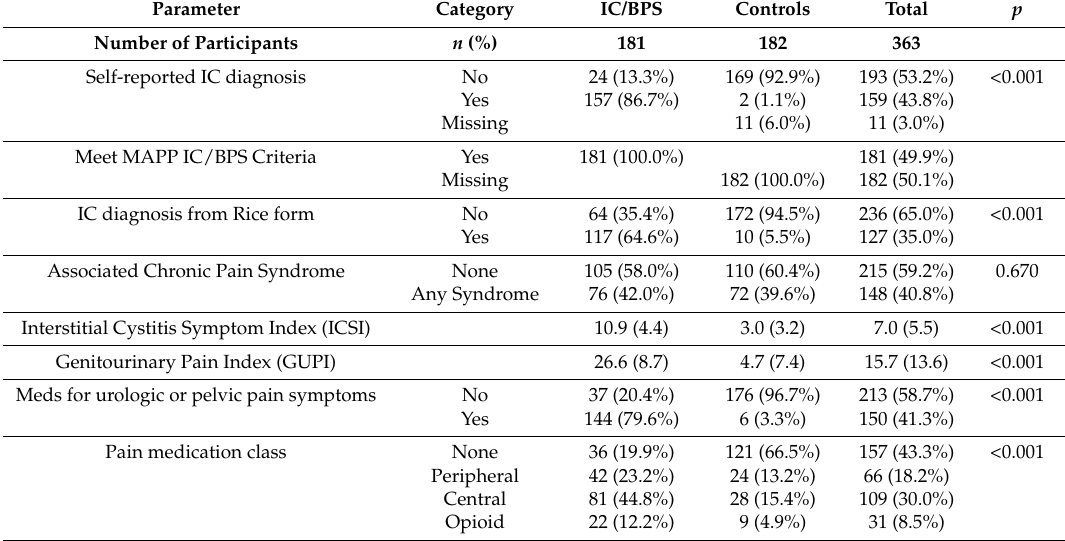
Table 2. Baseline clinical data.